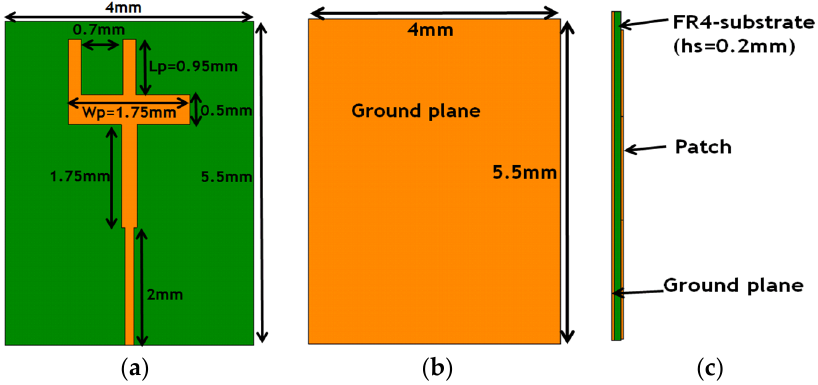
Figure 1. The geometry of the antenna: ( a ) ground plane, ( b ) bottom view and ( c ) side view.